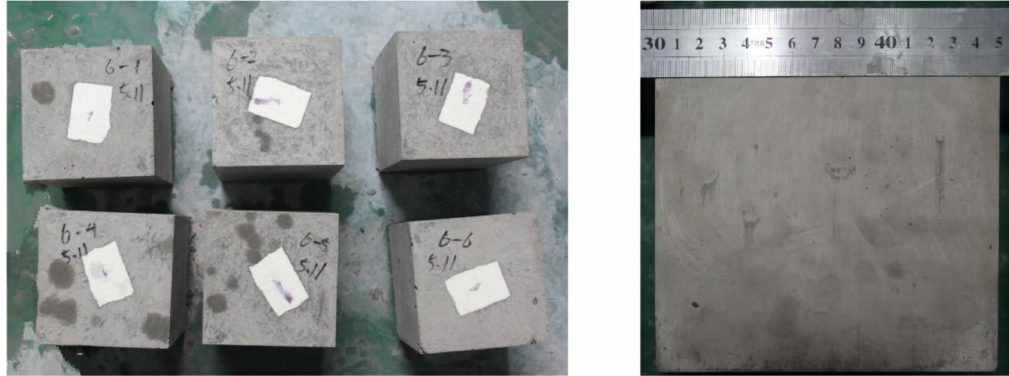
Figure 6. Part of the test